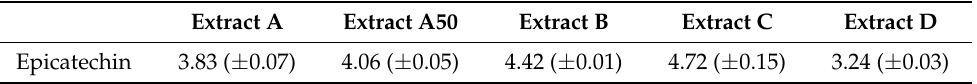
Table 9. Epicatechin absolute concentrations ( µ g/mL, mean ± SD) in the